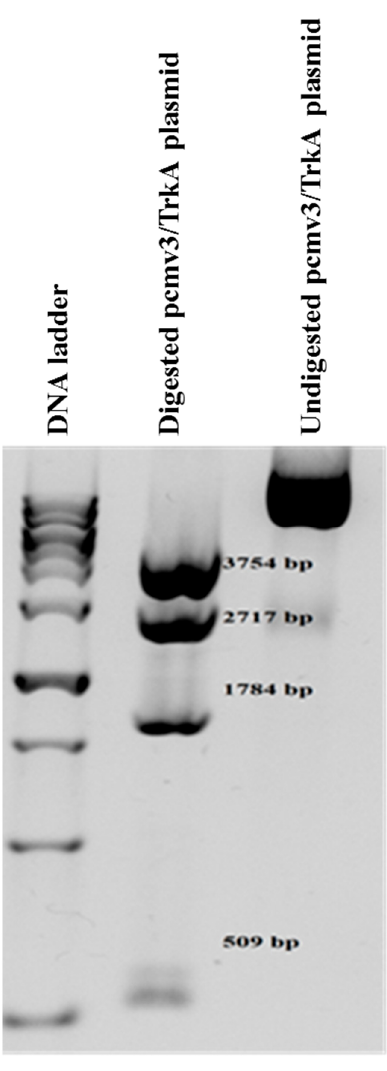
Figure 3. Restriction analysis of the pCMV3 ‐ TrkA expressing vector. The human pCMV3/TrkA plasmid was digested by Nco I and was then analyzed by gel electrophoresis. Four bands (509, 1784, 2717, and 3754 base pair fragments) were detected as indicators of plasmid